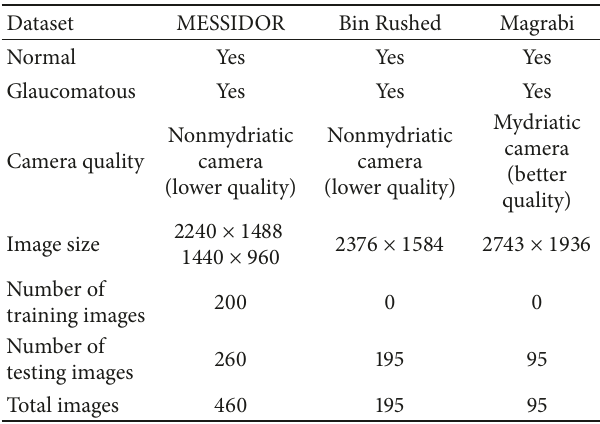
Table 1: Dataset